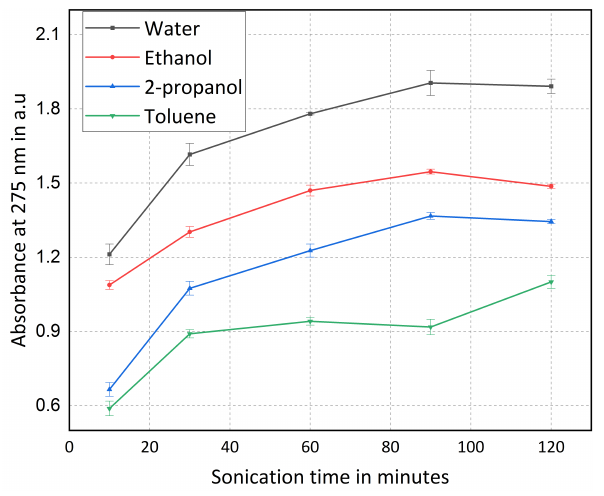
Figure 4. Rate of debundled CNT in solvents for different sonication